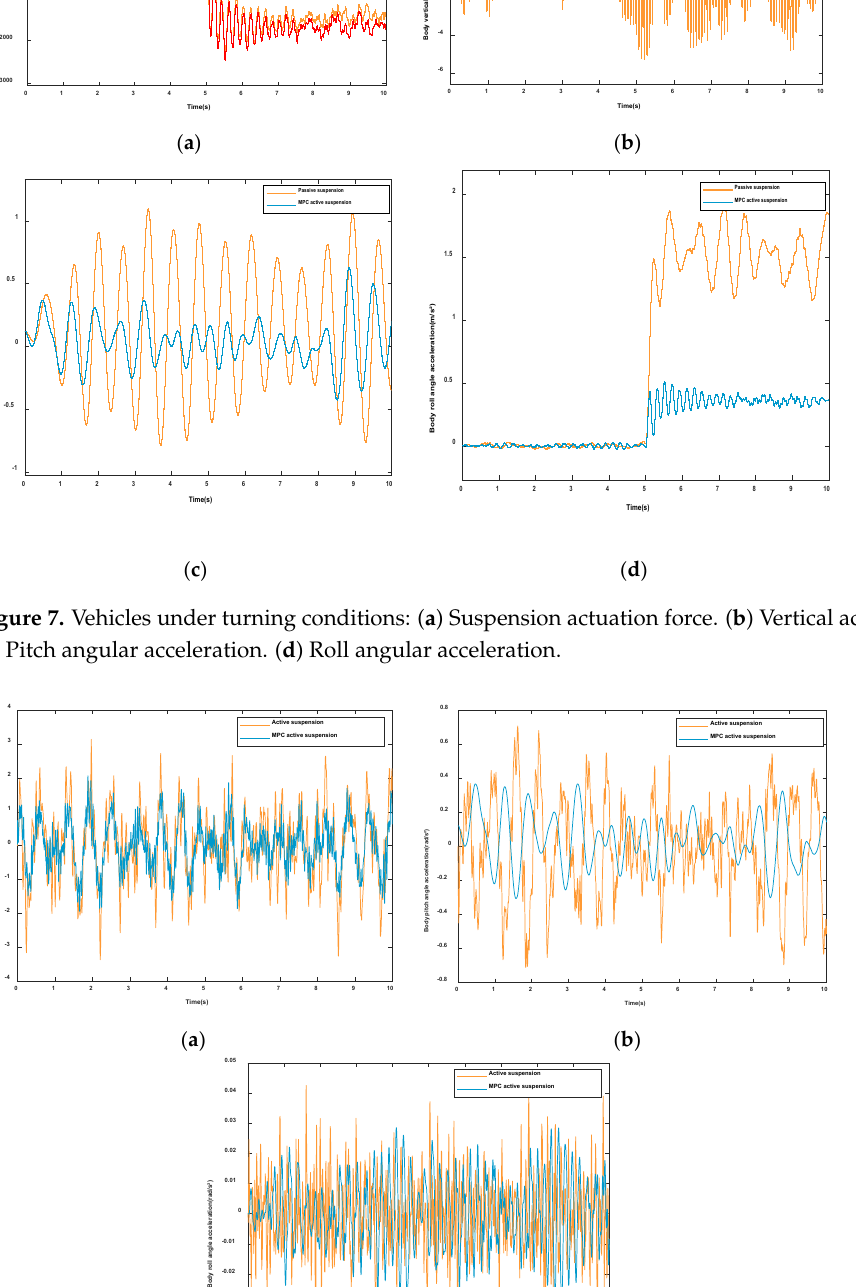
Figure 8. Comparing Results with Conventional Model Predictive Control: ( a )Vertical acceleration. ( b ) Pitch angular acceleration. ( c ) Roll angular